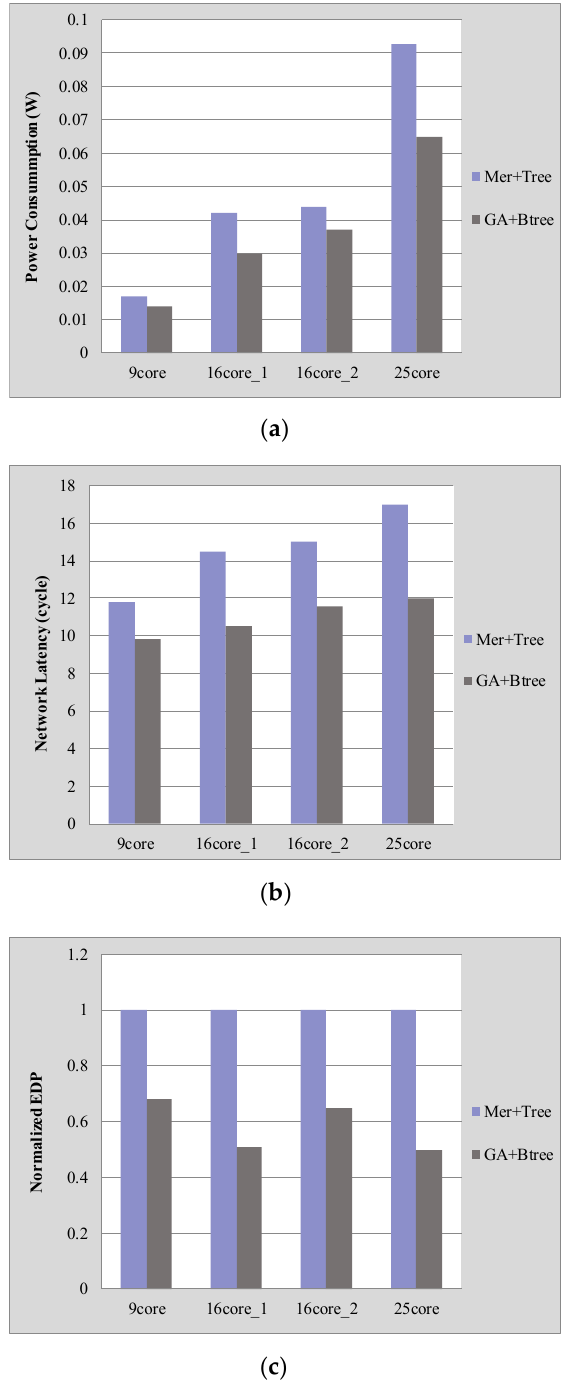
Figure 4. Performance comparison under different NoC platforms: ( a ) Power consumption comparisons; ( b ) Latency comparisons; ( c ) EDP comparisons.